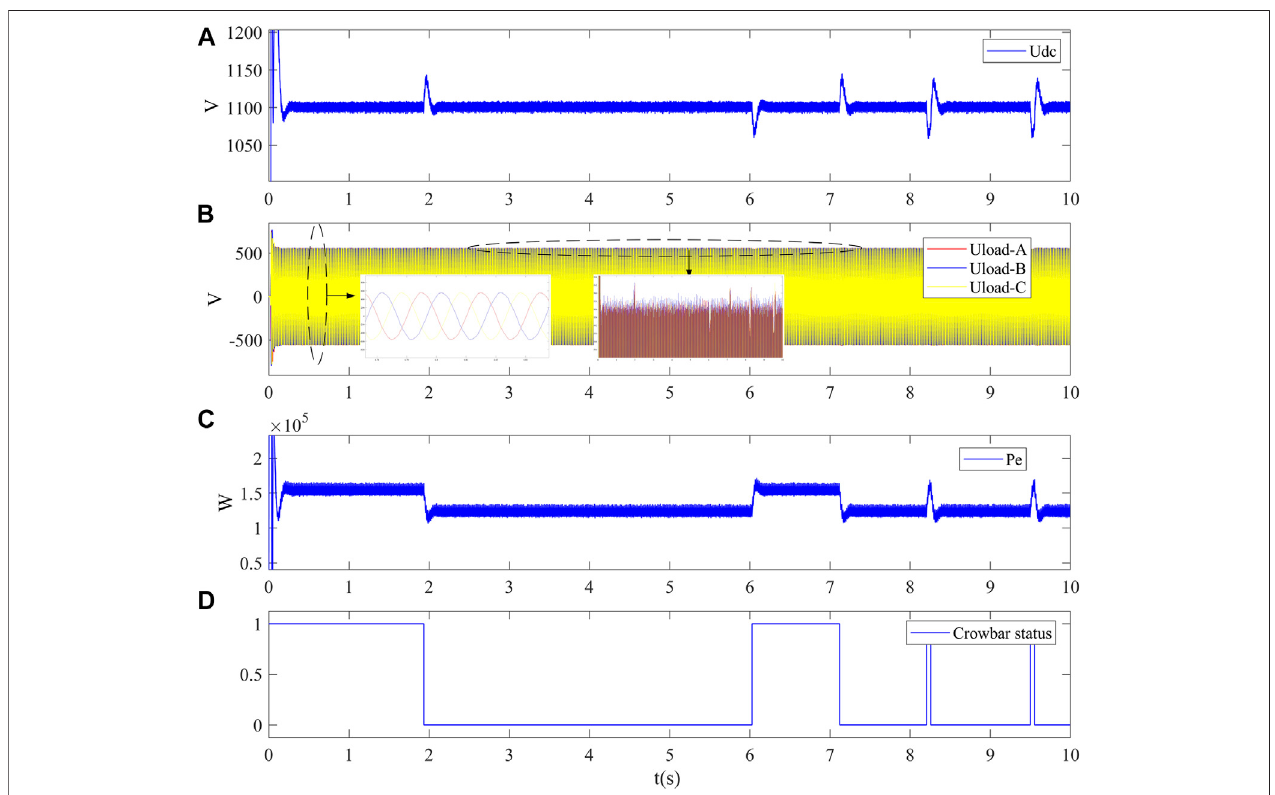
FIGURE 12 | The DC-link voltage, line-side voltage, power, and crowbar status in case 3. (A) The dc-link voltage (B) Detailed three-phase line-side voltage (C) Electrical power Pe (D) Crowbar